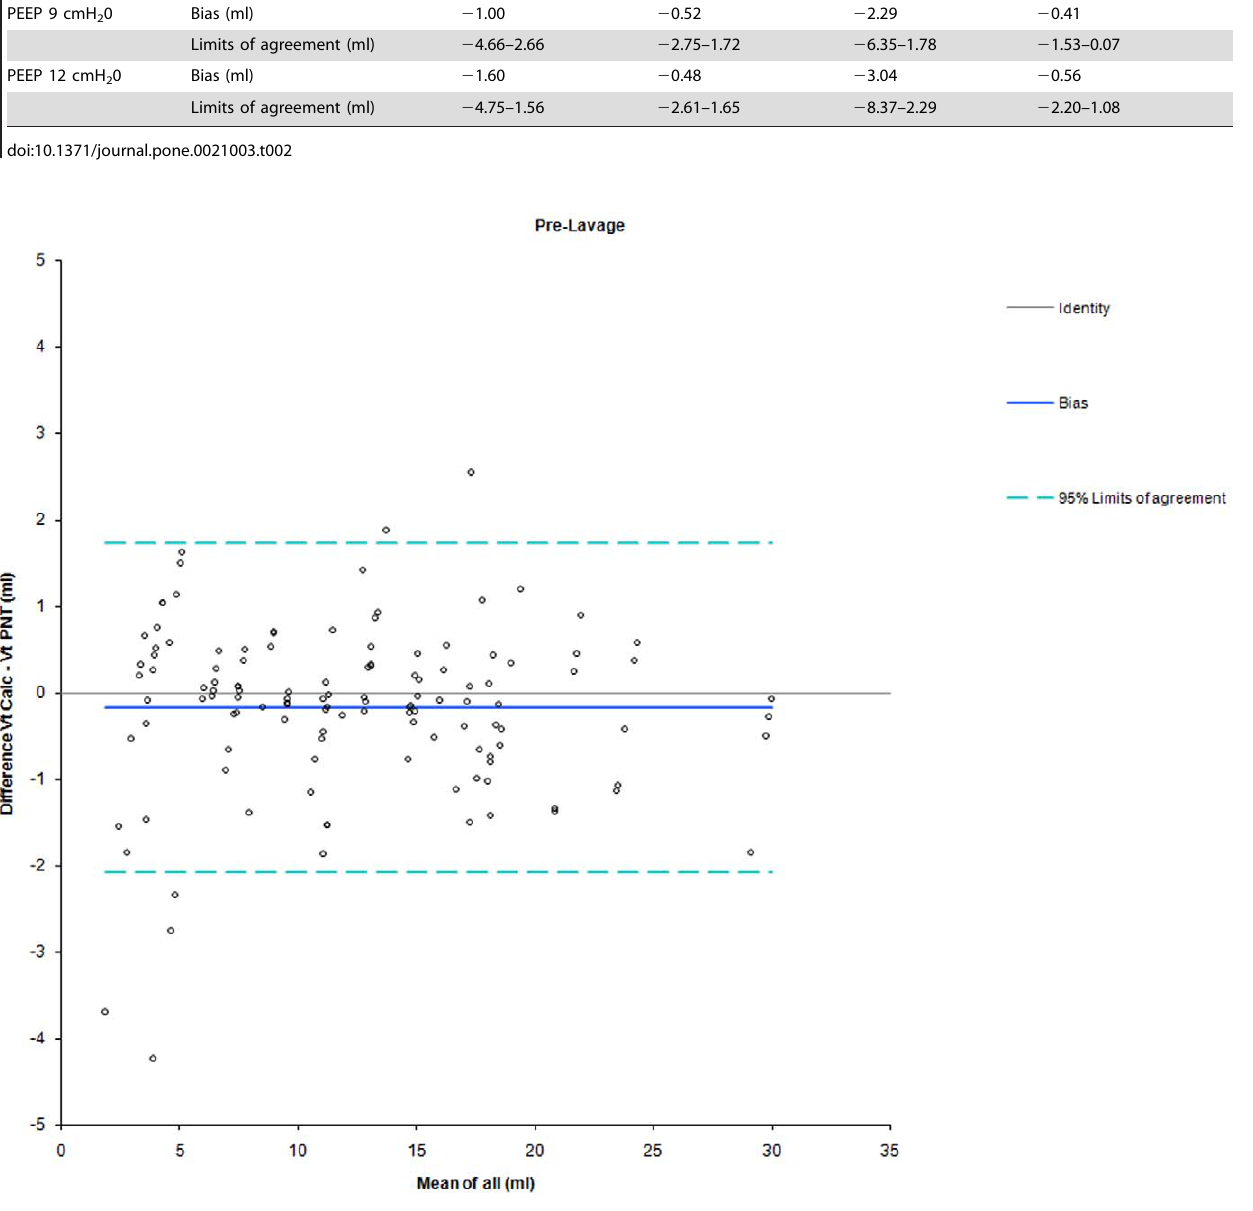
Figure 4. Bland-Altman Plot for comparison between VT calc and VT PNT during pre-lavage measurements. Shown are Line of Identity (grey line), Bias (blue line), and 95%-Limits of Agreement (dashed line). Calibration was performed at each PEEP level in all animals. Data points indicate the means of measurements in individual piglets at different PEEP levels. doi:10.1371/journal.pone.0021003.g004 PLoS ONE |